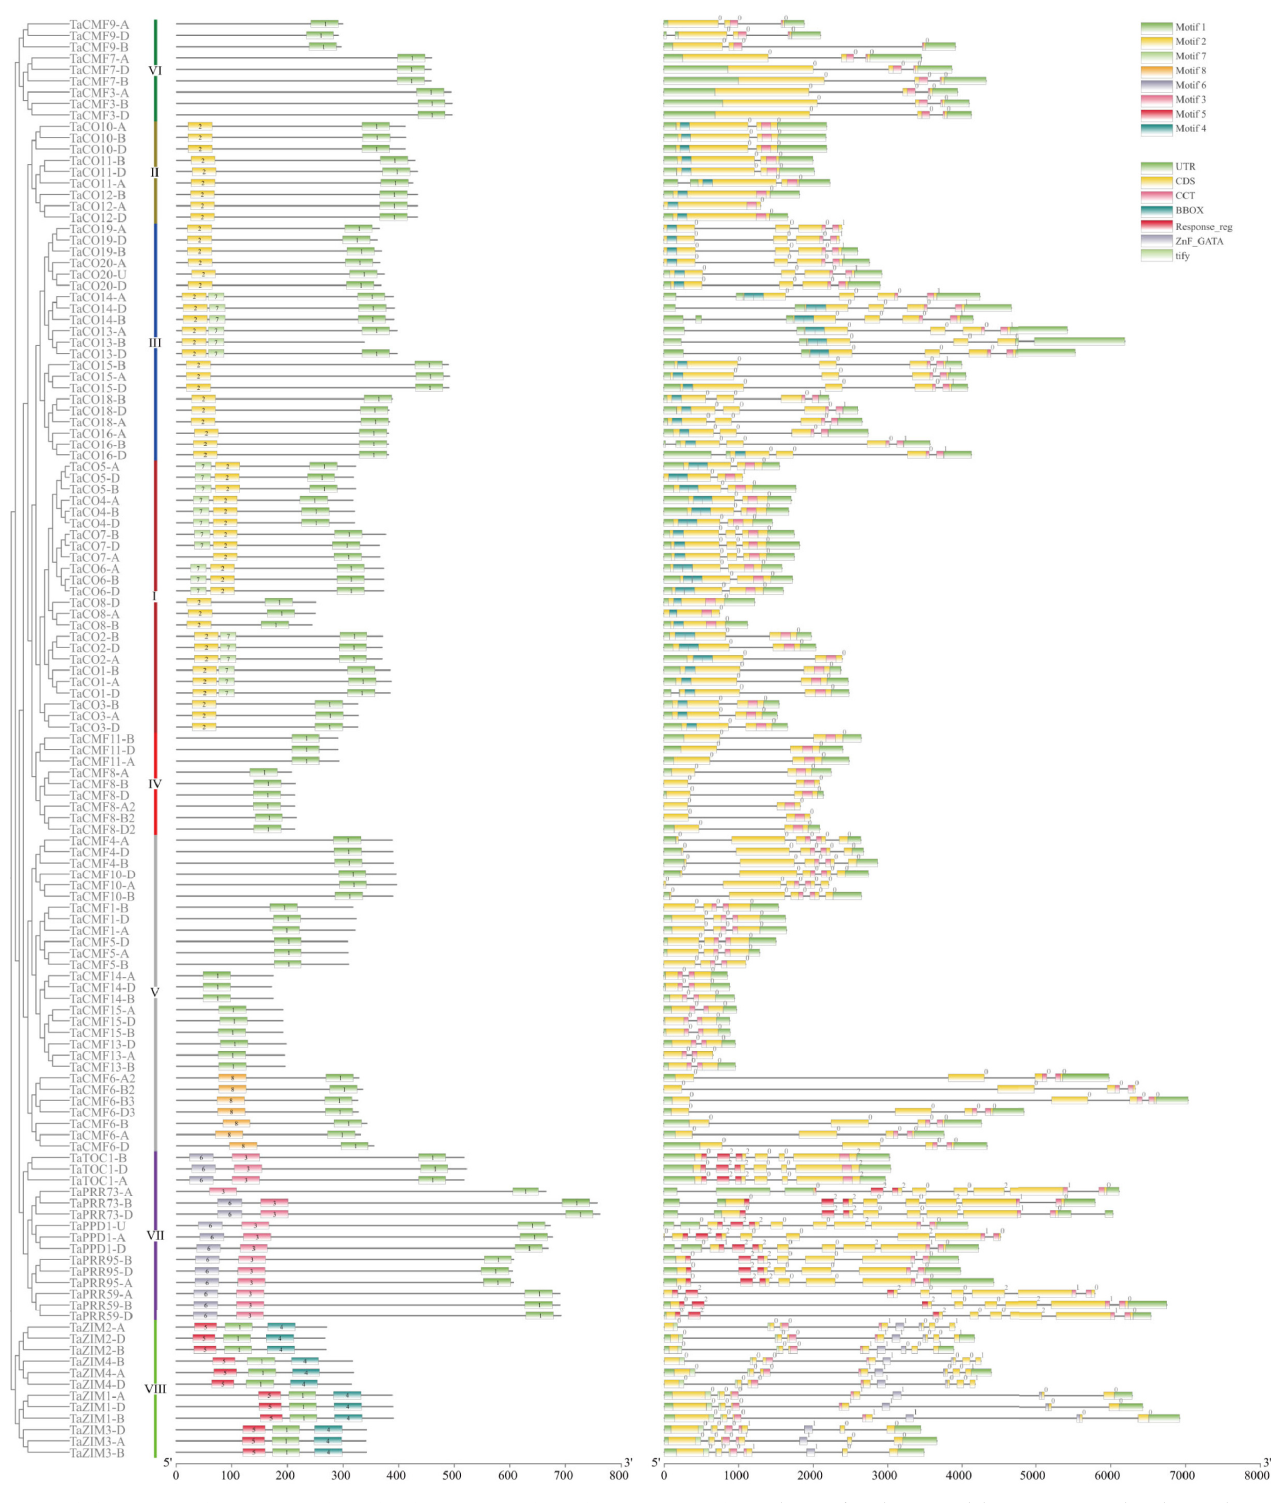
Fig 2. Phylogenetic analysis, conserved motif and structure analysis of CCT genes in wheat. The motifs and conserved domains were predicted using the MEME suite and the Batch CD-Search tool, respectively, and displayed using TBtools. Phylogenetic analysis of the proteins was performed using MEGA v6.0 following the UPGMA